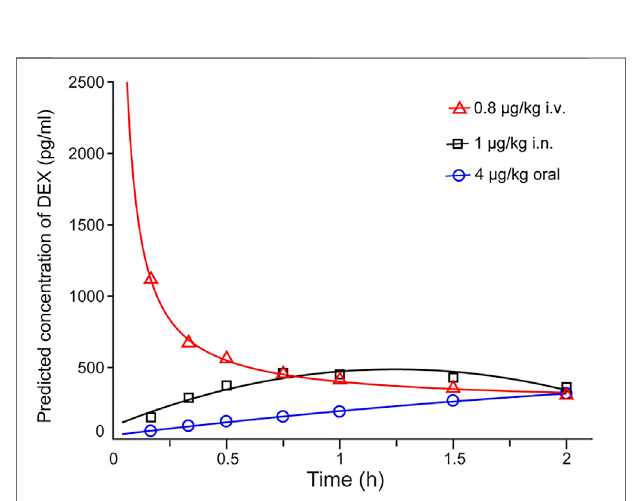
FIGURE 3 | Predicted DEX plasma concentration – time curve. Plasma concentrations of DEX reached peak values after IV injection and decreased gradually, increased after IN infusion and slowly increased with oral administration.Thetimetoachieve220 pg/mlofDEXconcentrationwas immediately after IV infusion, 13.2 min after IN and 70.3 min after oral administration. DEX = dexmedetomidine; I.V. = intravenous; I.N. = intranasal.